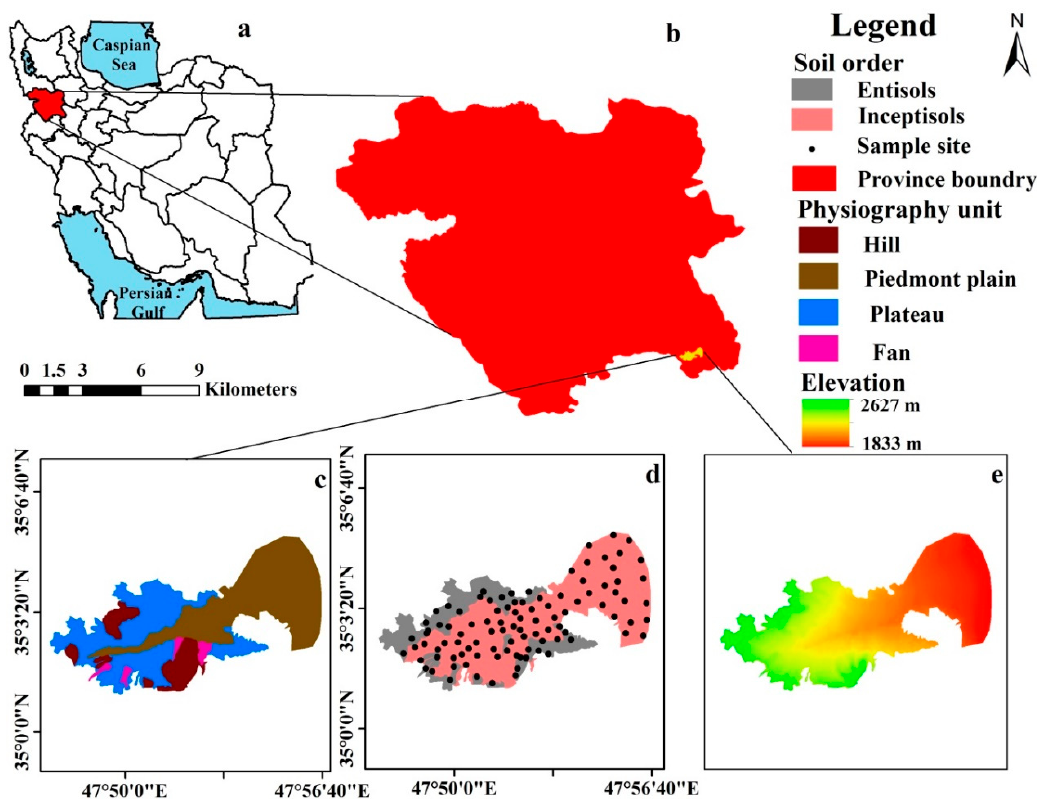
Figure 1. Location map of the study area within Iran ( a ) and Kurdistan Province ( b ), physiography map ( c ), soil map with soil sampling locations ( d ), and elevation map ( e ).